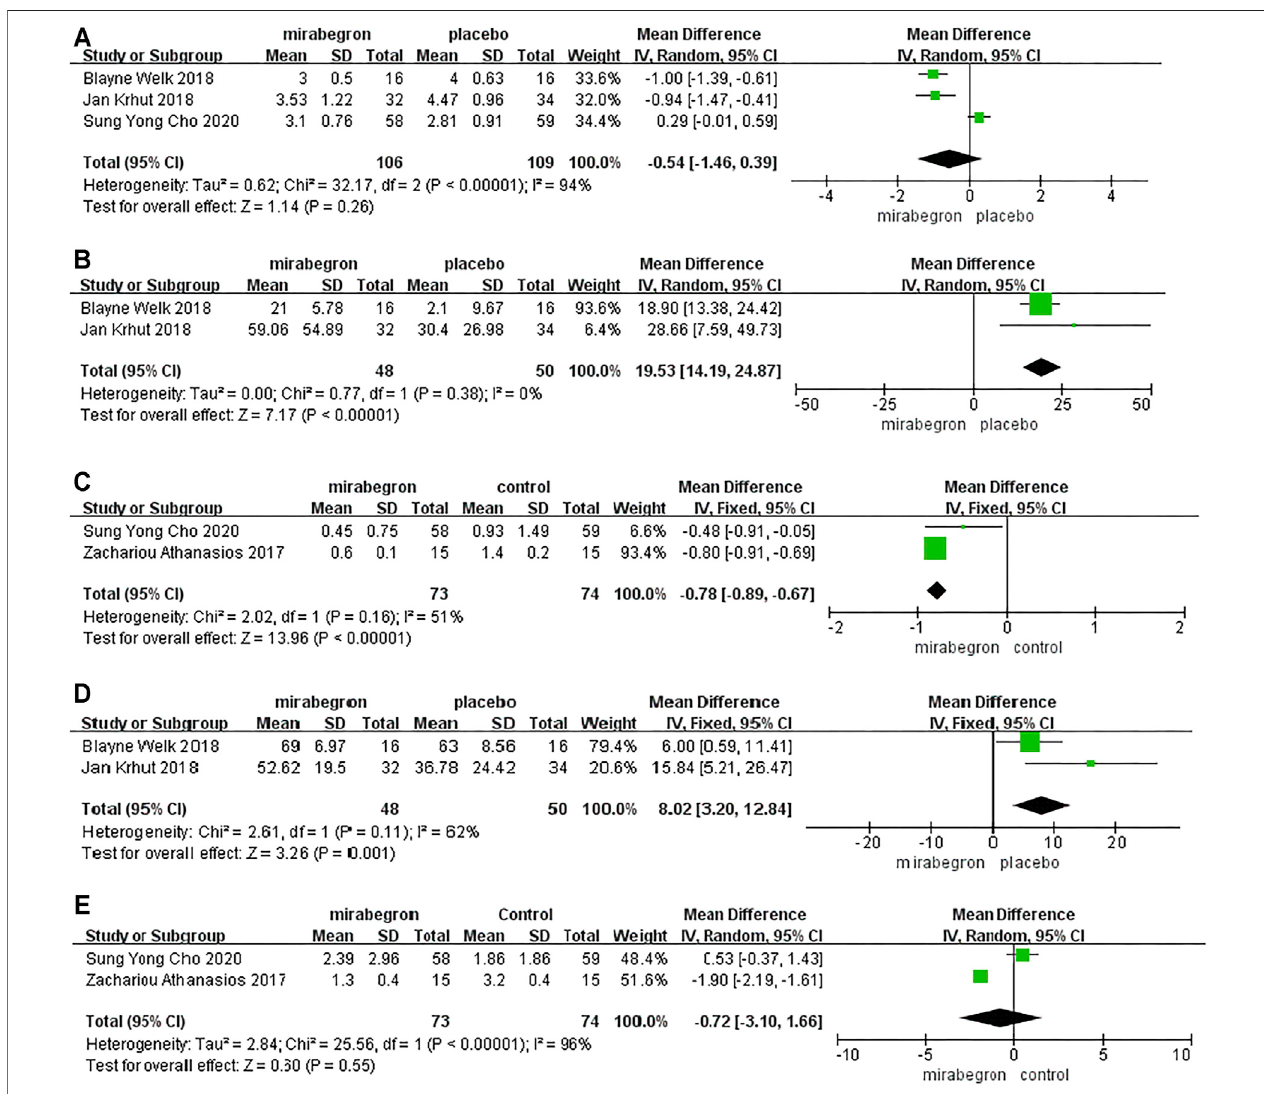
FIGURE 2 | Forest plots showing changes in (A) patient perception of bladder condition (PPBC), (B) bladder compliance (C) urinary incontinence episodes, (D) Incontinence Quality of Life (I-QOL), and (E) urinary urgency episodes.